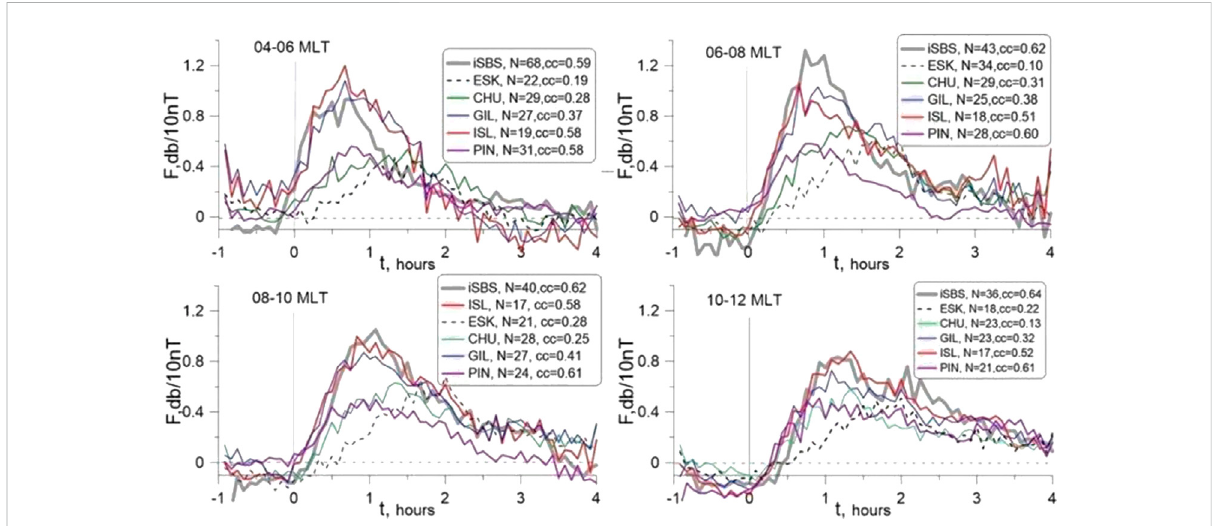
FIGURE 2 Response functions for active periods in the pre-noon sector at different Churchill line riometers (colored lines) together with response functionforisolated substorms(thick greyline,fromPaper1)inthemiddleofauroralzone.ThenumberofintervalsusedintheLPFderivation(N)and correlation coef fi cient (cc) between predicted and observed absorption values are shown in the legend. t corresponds to the time delay after contributing